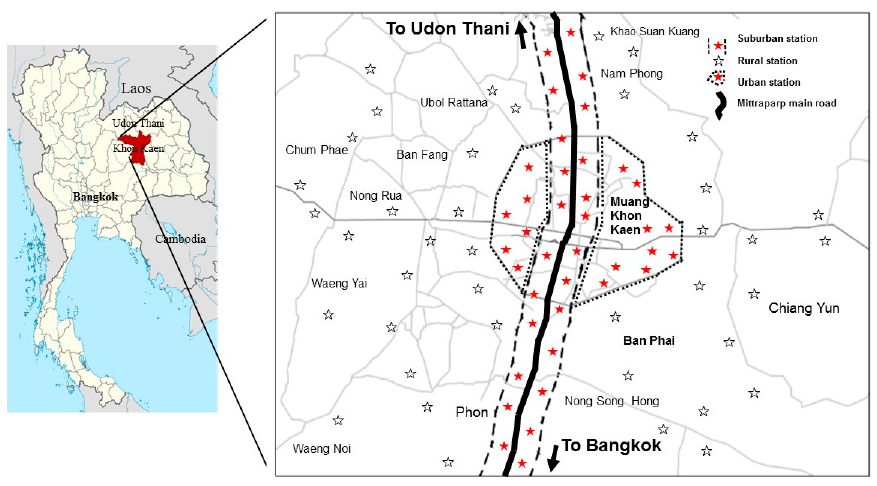
Figure 1. Map of Khon Kaen, the study site of the gasoline stations.